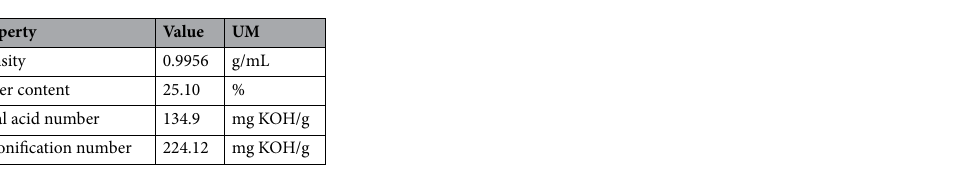
Table 3. The physical characteristics of the pyrolysis bio-oil.